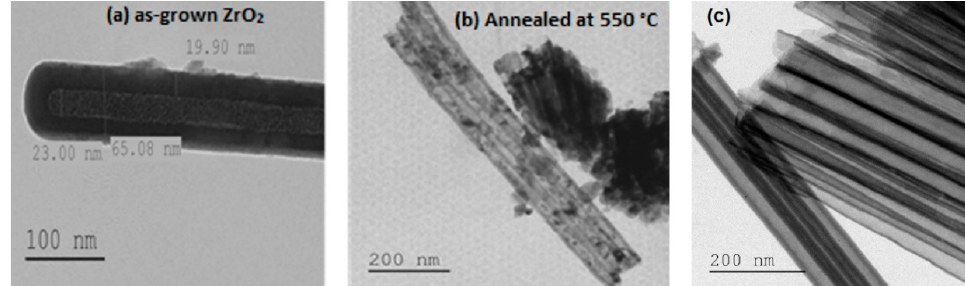
Figure 2. TEM images of the ZrO 2 nanotubes: ( a ) as-grown, ( b ) annealed at 550 °C in air, and ( c ) transparency of ZrO 2 nanotubes annealed at 550 °C.